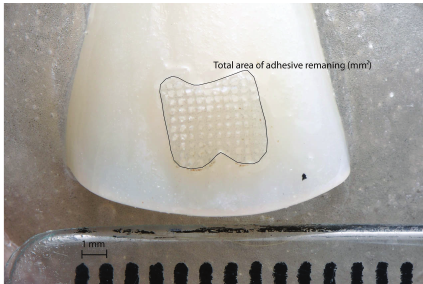
Figure 1: Photograph for analysis of the total area of adhesive bonded to the tooth after debonding of the bracket. Note that a scale was used to serve as reference for the digital scale. Thereafter, the area was calculated on the software Adobe Photoshop